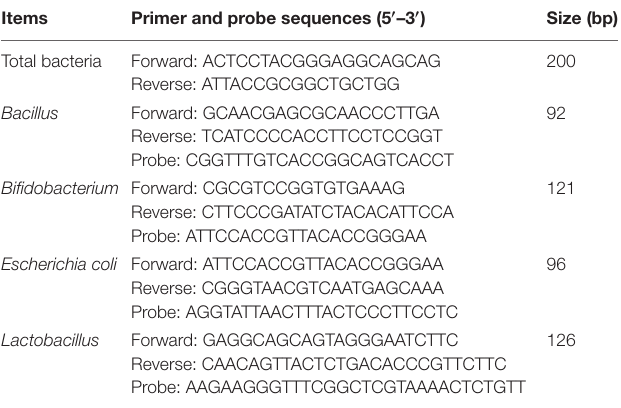
TABLE 3 | Sequences of primers and probes for quantitative RT-PCR. Items Primer and probe sequences (5 (cid:48) –3 (cid:48)